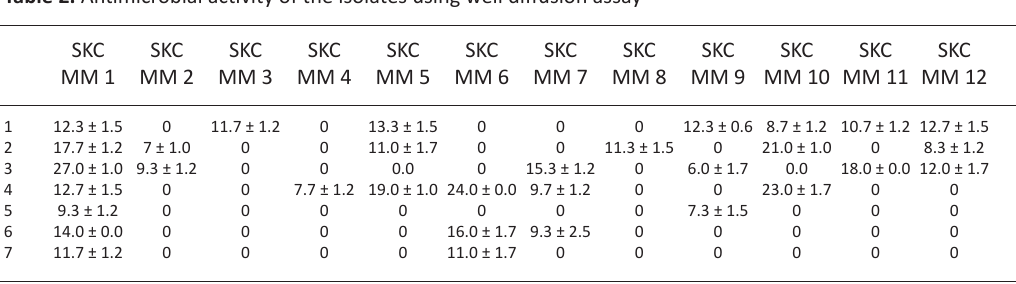
Table 2. Antimicrobial activity of the isolates using well diffusion